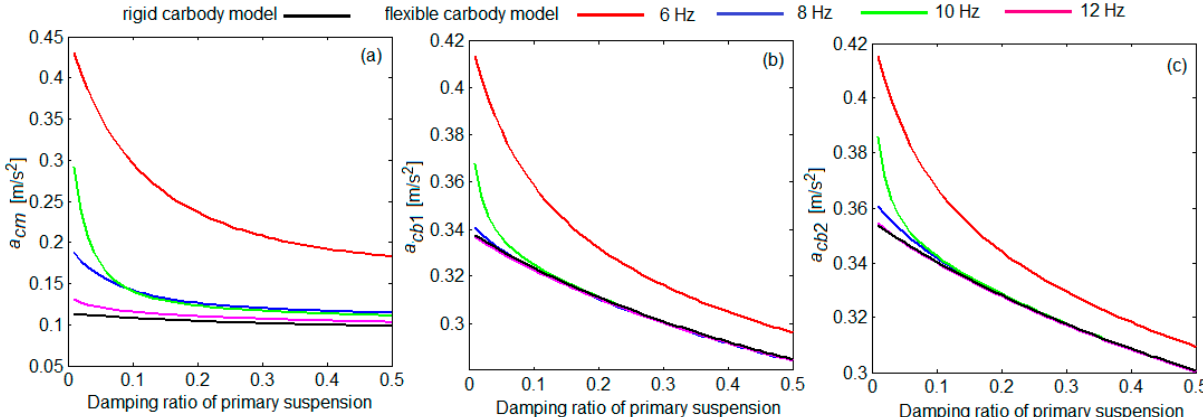
Figure 9. Influence of the carbody vertical bending upon the root mean square of acceleration in correlation with the damping ratio of primary suspension: ( a ) at the carbody centre; ( b ) against the front bogie; ( c ) against the rear bogie.